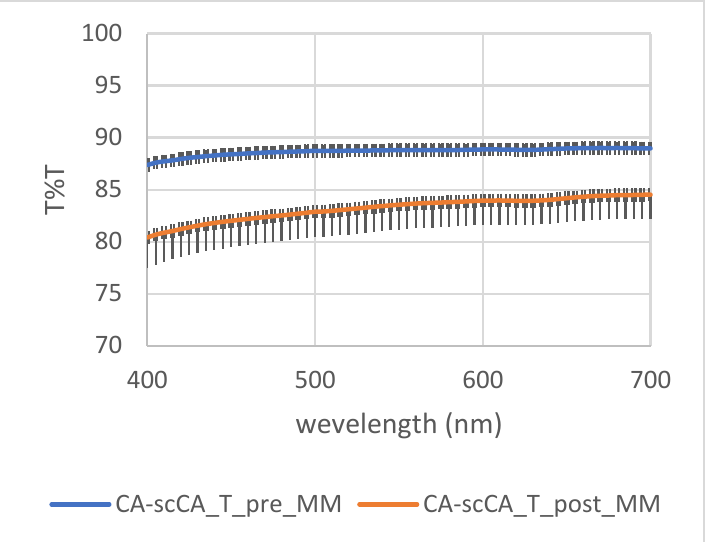
Figure 7. Comparison of transmittance values of the Scheu CA Pro + with Carbon L1 printer before and after aging. The curves are the average of nine spectrophotometry measurements ± SD. The highest percentage variation was reported by the RapidShape D100+ printer with Sheu CA Pro+ of − 8.8 and − 5.1, respectively, recording a significant loss of transparency. This printer with this material had mean values of 87.587 ± 1.34 and 88.853 ± 1.29 before aging and 79.878 ± 0.49 and 84.304 ± 0.76 after aging. On the other hand, non-significant variation ( p > 0.01) is found with the Zendura FLX material for the three printers considered in the study. Prodways LD20 printer with this second material presented transmittance values, at 400 nm and 700 nm, of 85.643 ± 1.90 and 88.408 ± 1.67 at T0 and 85.837 ± 1.12 and 88.029 ± 1.20 at